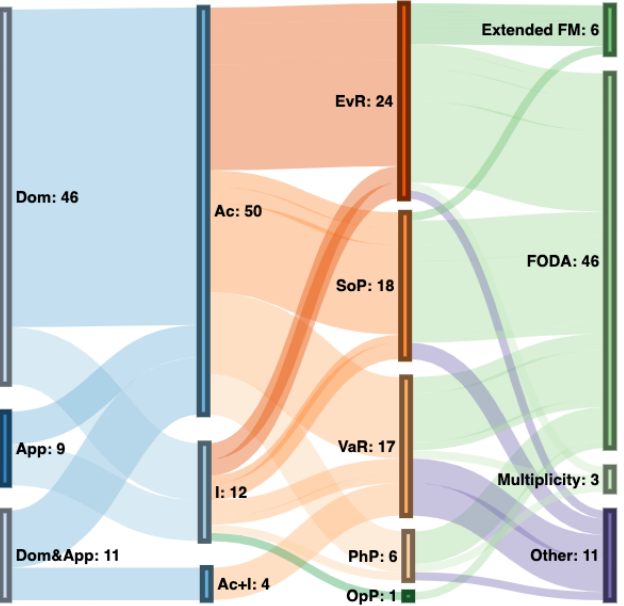
Figure 21. Relationships between stages (RQ1), origins (RQ3), validation levels(RQ4), and FMs (RQ5). The first vertical axis represents the stages defined for RQ1, which considers domain engineering (Dom), application engineering (App), and both stages (Dom&App). The second vertical axis represents the origin of proposals defined for RQ3, comprising the academy (Ac), industry (I), and both origins (Ac + I). The third vertical axis represents the validation levelfor each proposal, comprising the categories of evaluation research (EvR), solution proposal (SoP), validation research (VaR), philosophical paper (PhP), and opinion paper (OpP). The fourth and last vertical axis represents the FM representation